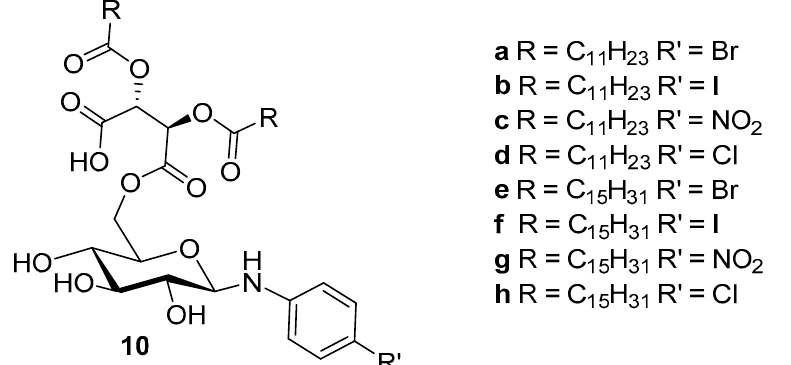
Figure 4. Structures for sugar based glycolipid derivative 10a – h [43].